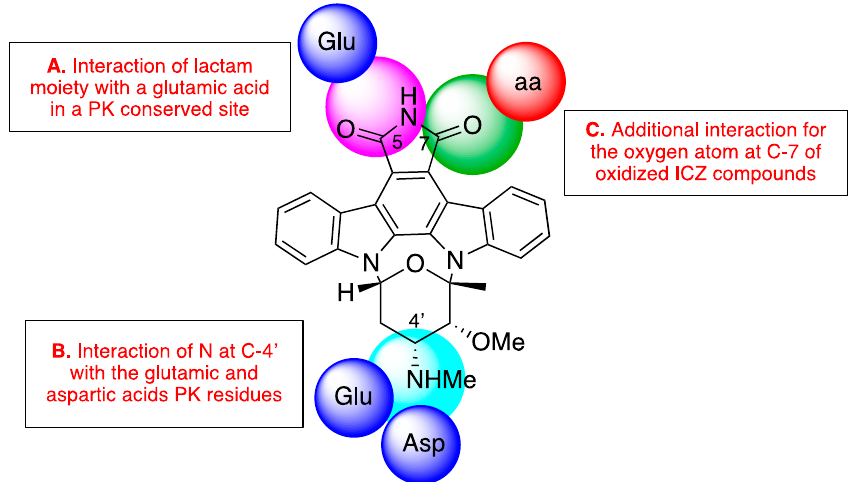
Figure 5. Interaction model for staurosporine (STS)-related compounds with protein kinases (PKs) [33–36]. ( A ), ( B ) and ( C ) describe the key-interactions with conserved residues at the active site.